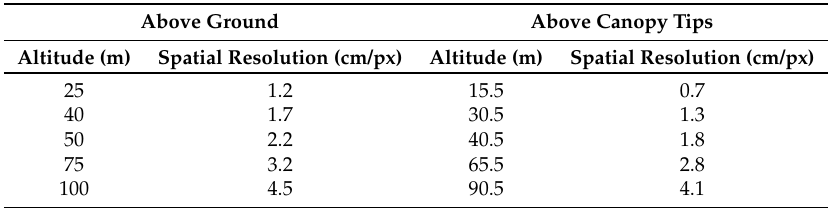
Table 1. Flight parameters for the